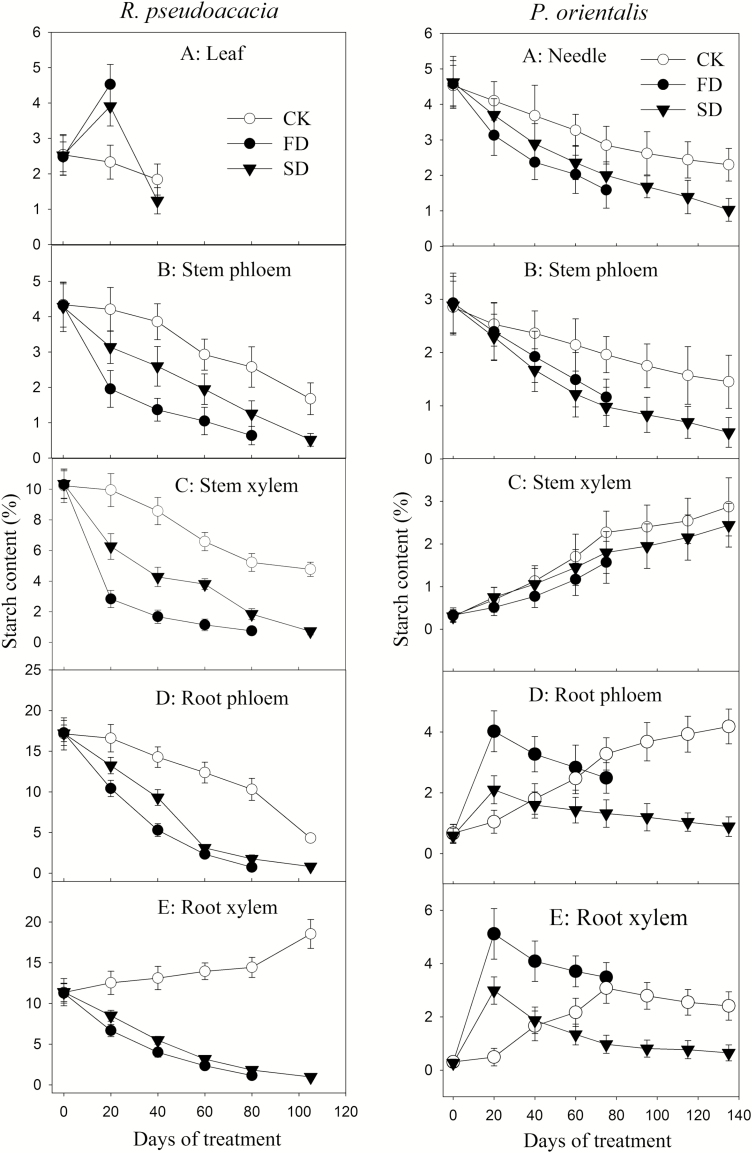
Change in St (starch) content during drought. A–E in the left panel are the St content of the leaves, stem phloem, stem xylem, root phloem and root xylem of Robinia pseudoacacia, respectively. A–E the in right panel are the St content of needles, stem phloem, stem xylem, root phloem and root xylem of Platycladus orientalis, respectively.